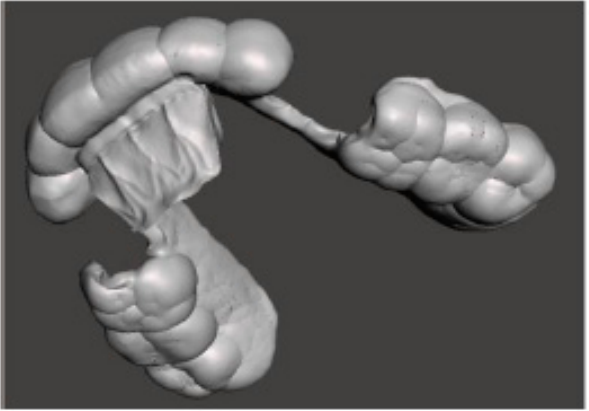
Figure 10. Lower arch device (M.O.R.A. appliance) to be used during the day thanks to its comfortability and lower impact on social life.